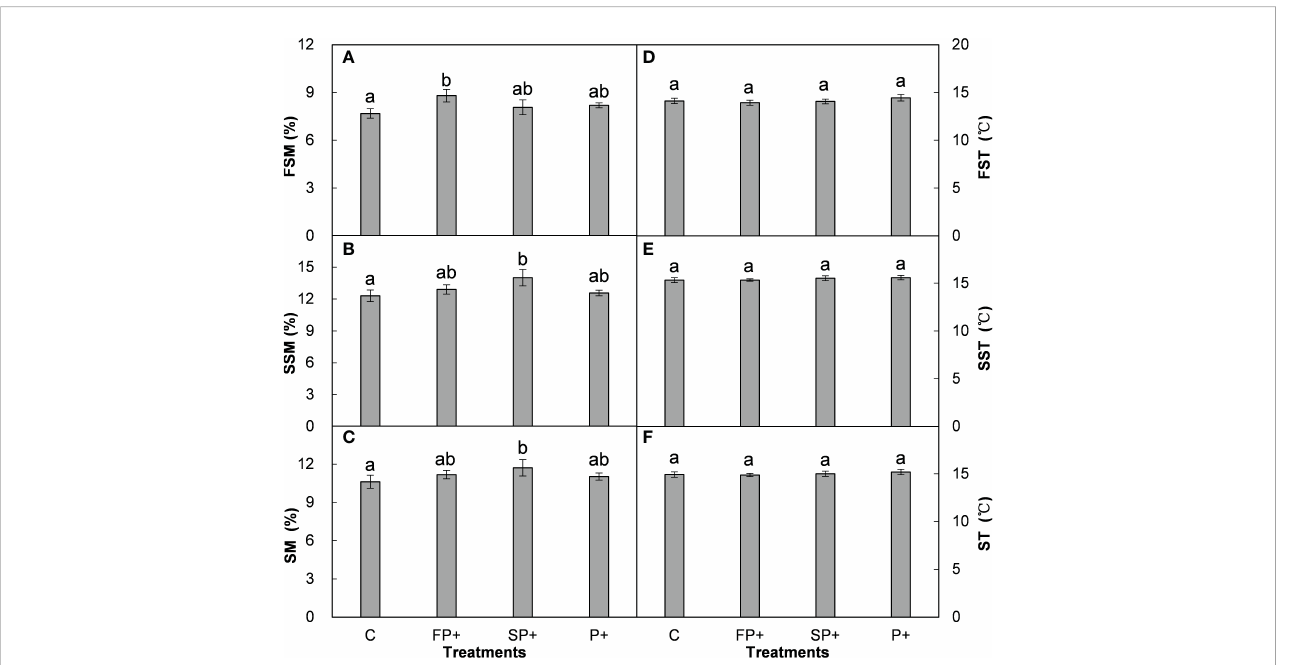
FIGURE 2 Effect of increasing fi rst half and late growing-season precipitation on fi rst half of (FSM) (A) , second half of (SSM) (B) , and entire (SM) (C) growing-season soil moisture, fi rst half of (FST) (D) , second half of (SST) (E) , and entire (ST) (F) growing-season soil temperature. Different letters indicate signi fi cant differences among different precipitation treatments ( P < 0.05), the same in Figures 3,